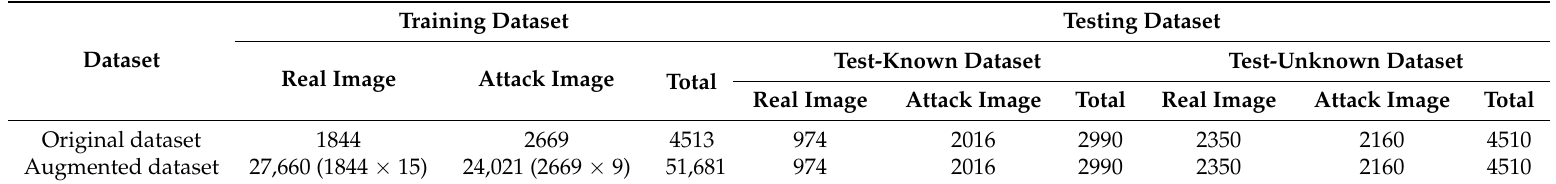
Table 4. Description of Warsaw-2017 dataset in our experiment (with augmentation of training dataset).